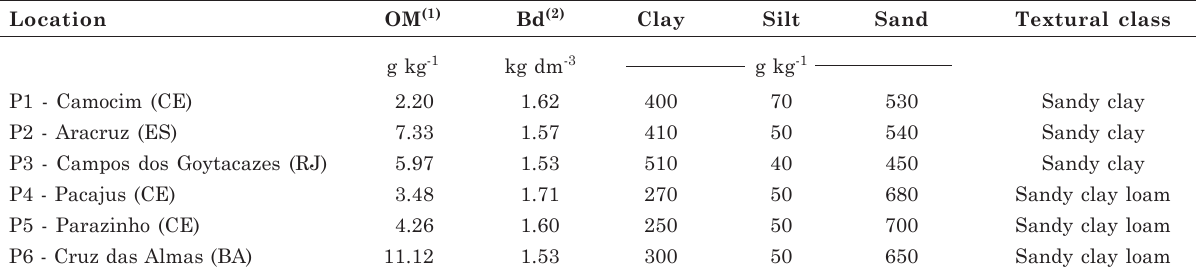
(1) OM: organic matter. (2) Bd: soil bulk density. Clay < 0.002 mm, Silt 0.002-0.05 mm, and Sand 0.05-2.00